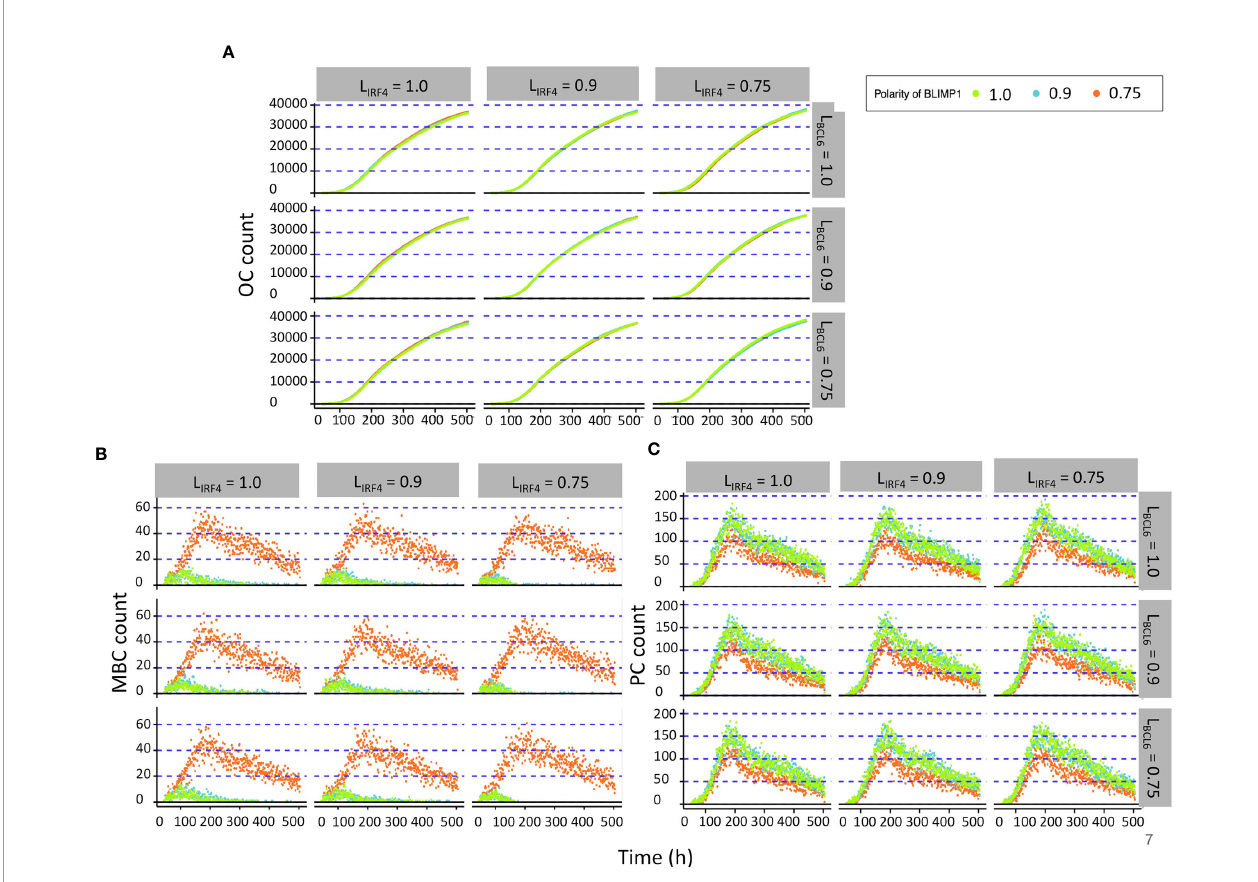
FIGURE 6 | Results from the second set of simulations ( Table 3 ). (A) Accumulated OCs, (B) relative MBC, and (C) PC count during the GC reaction. At the top of each panel column, the IFR4 polarity level is indicated. To the right of each panel row, the BCL6 polarity level is indicated. The colors indicate the different BLIMP1 polarity